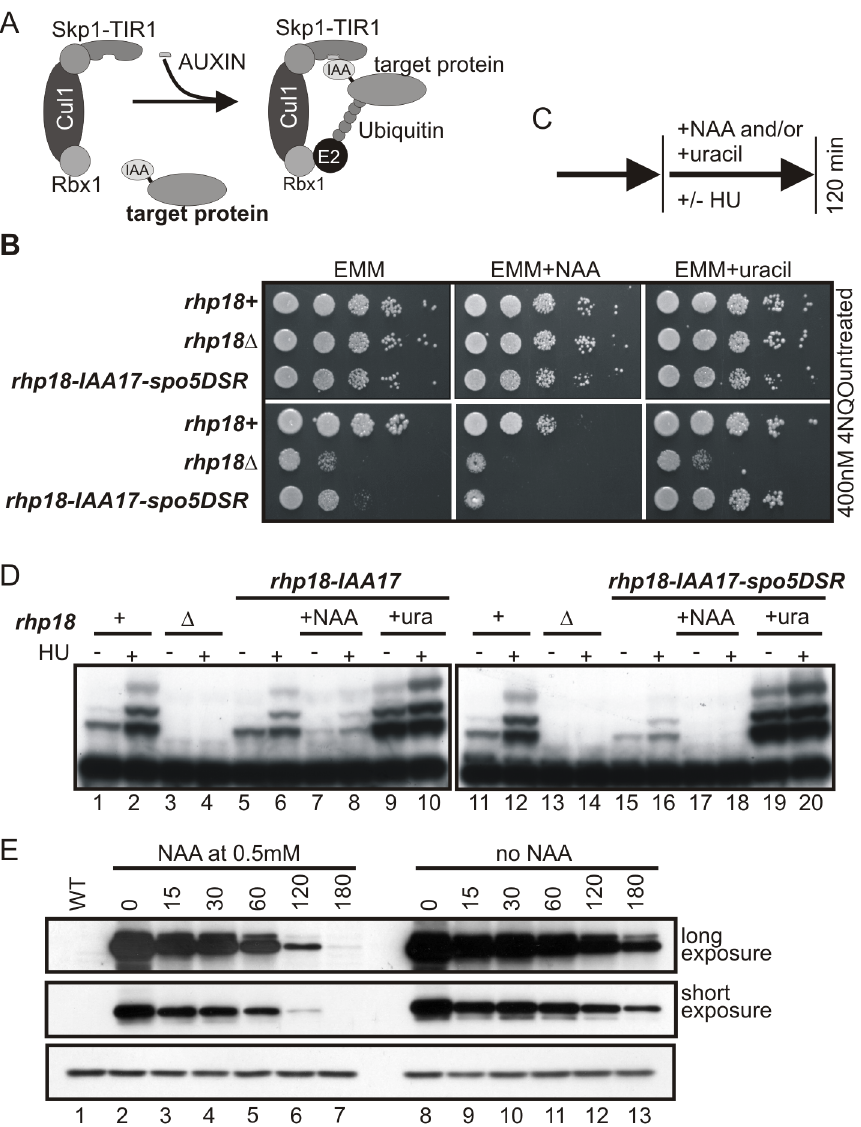
Figure 5. Use of an auxin-inducible degron allows for the generation of a conditional rhp18 mutant strain. ( A ) Cartoon of the IAA17 degron system: addition of auxin allows binding of the TIR adaptor (fused to Skp1) to the IAA17 tag (IAA), which is fused to the target protein. This induces ubquitination and proteasome degradation. ( B ) Strains AW617 ( rhp18 + ), YDP273 ( rhp18 D ) and YDP231 ( rhp18 D , P urg1lox -rhp18-HAIAA17- spo5DSR ) were serially diluted 10-fold in water and spotted on EMM + L plates supplemented as shown with uracil at 0.25 mg/ml, NAA at 0.5 mM and/ or 4NQO at 400 nM. Time of incubation at 30 u C: Top panels 3 days, bottom panels 5 days. ( C ) Schematic of experimental procedure used in D. HU = hydroxyurea, NAA = 1-naphthaleneacetic acid. ( D ) Ubiquitination of PCNA is abolished in P urg1lox -rhp18-HAIAA7-spo5DSR cells in the presence of NAA. Logarithmically growing AW617 ( rhp18 + ), YDP273 ( rhp18- delete), YDP210 ( rhp18- delete, P urg1lox -rhp18-HAIAA17 ) and YDP231 ( rhp18- delete, P urg1lox - rhp18-HAIAA17-spo5DSR ) cells cultured in EMM + L at 30 u C untreated ( 2 ) or treated with 10 mM HU ( + ) and grown for a 120 minutes or grown for 120 minutes in the presence of NAA at 0.5 mM or uracil at 0.25 mg/ml. Total protein extracts were separated by SDS PAGE prior to Western blotting using anti-PCNA antibody. ( E ). The auxin degron promotes protein degradation upon ‘‘shut-off’’. P urg1/lox . YDP210 ( rhp18- delete, P urg1lox -rhp18-HAIAA17